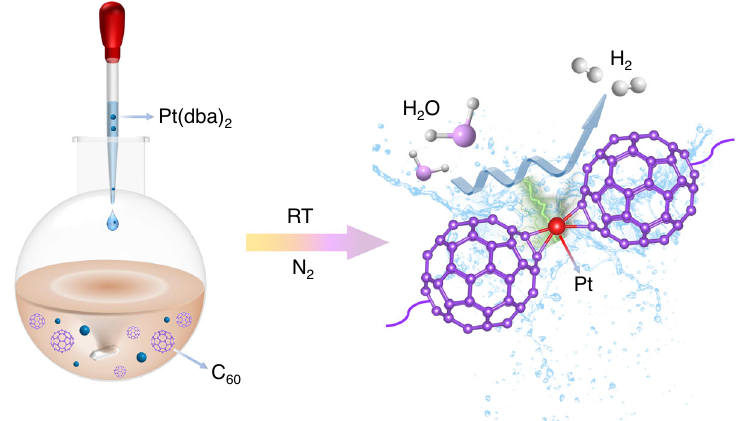
Fig.1|SyntheticschemeofPt/C 60 catalysts. ThetoluenesolutionofPt(dba) 2 and C 60 (molar ratio: n (C 60 ): n (Pt(dba) 2 )=1:1, 2:1, and 4:1, respectively) was stirred at room temperature under nitrogen, in which the dba ligands were completely